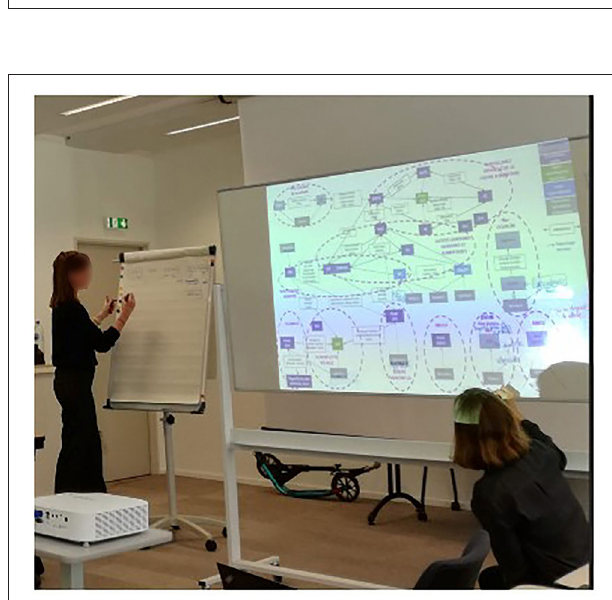
FIGURE 4 | Revision of the stakeholder diagram with the participants of the first workshop in